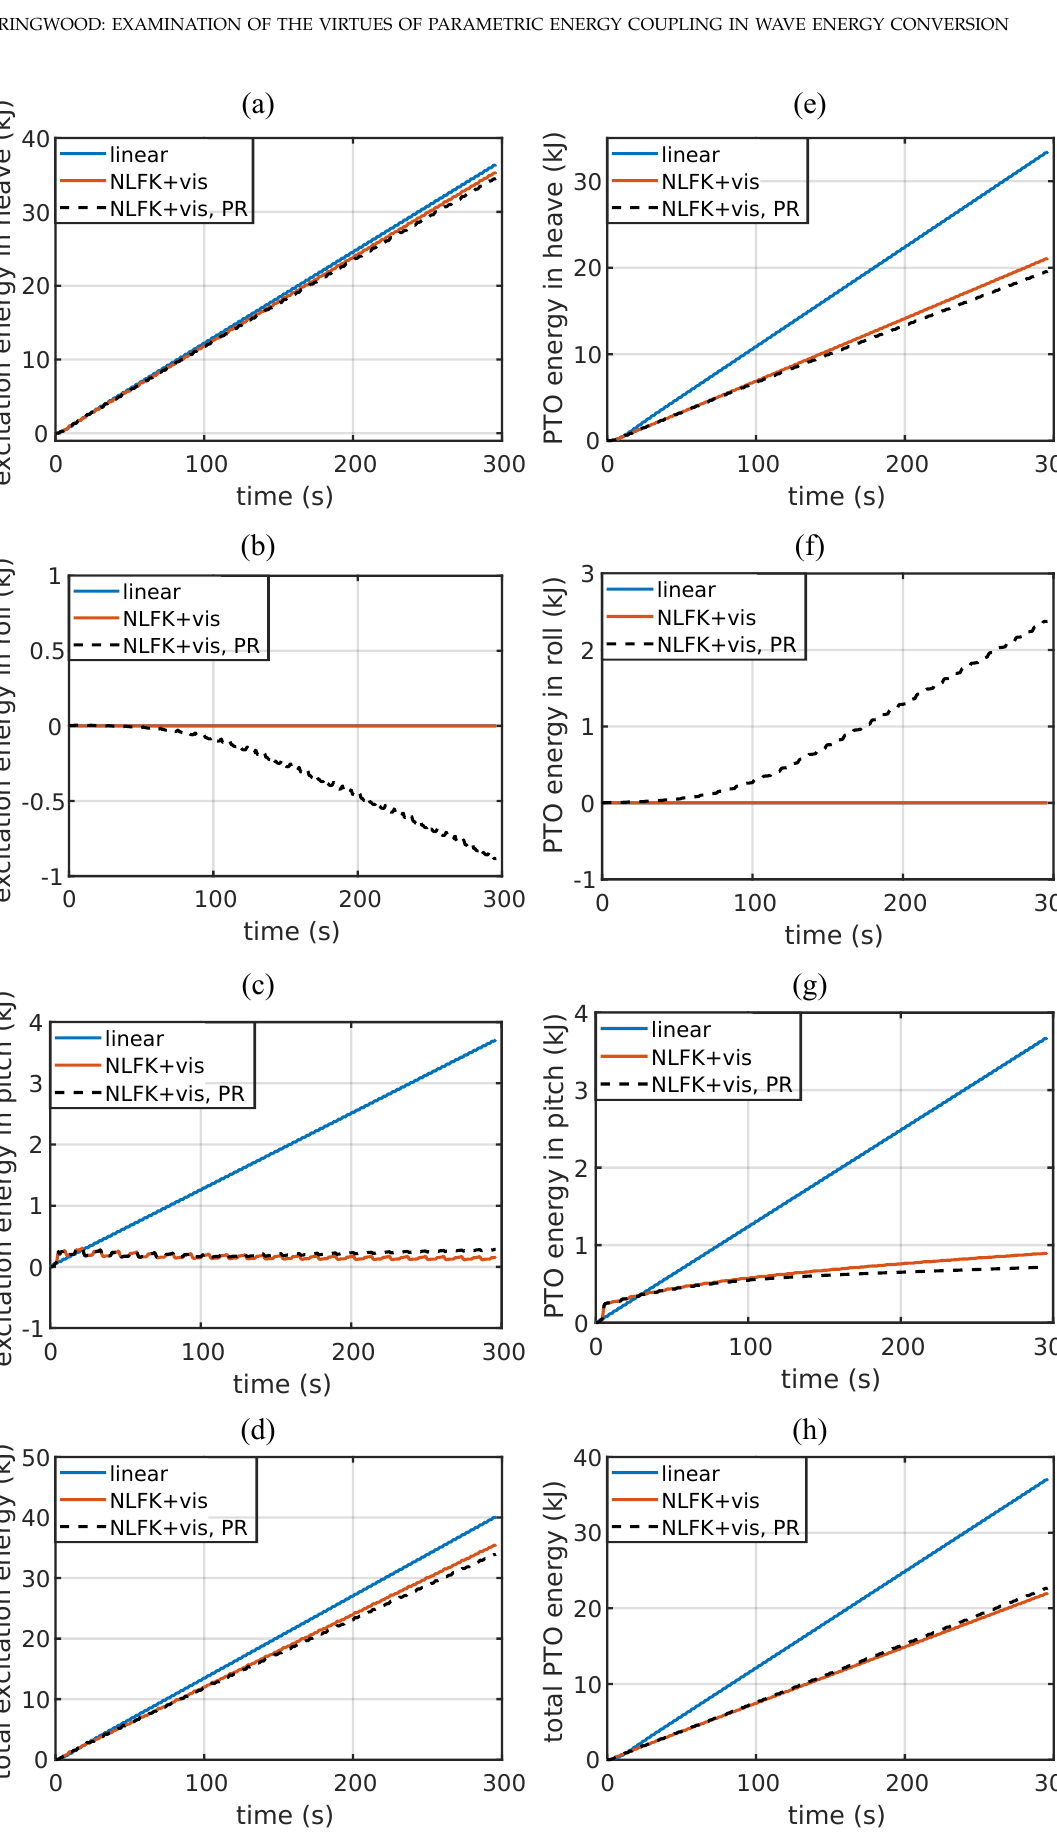
Fig. 8. Energy transfer between different DoFs illustrated by excitation energy in (a)-(d), and PTO energy in